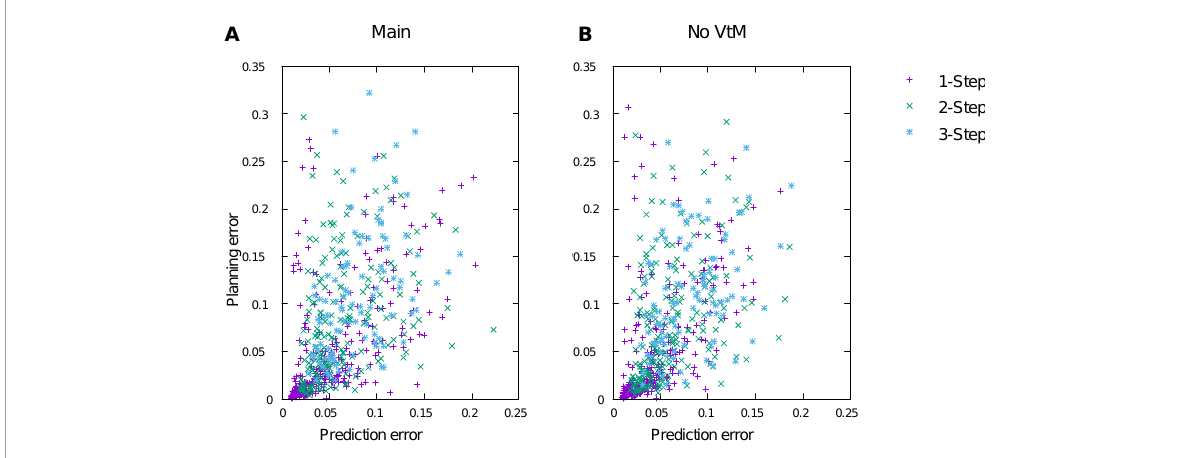
FIGURE8 Planning accuracy plotted against prediction accuracy for all 1-, 2-, and 3-step sequences in the test set. (A) Main experiment. (B) Baseline B1 (No VtM). Error unit: length of the cloth. For predictions, errors are calculated for the µ component of the prediction. Unit is the length of the side of the